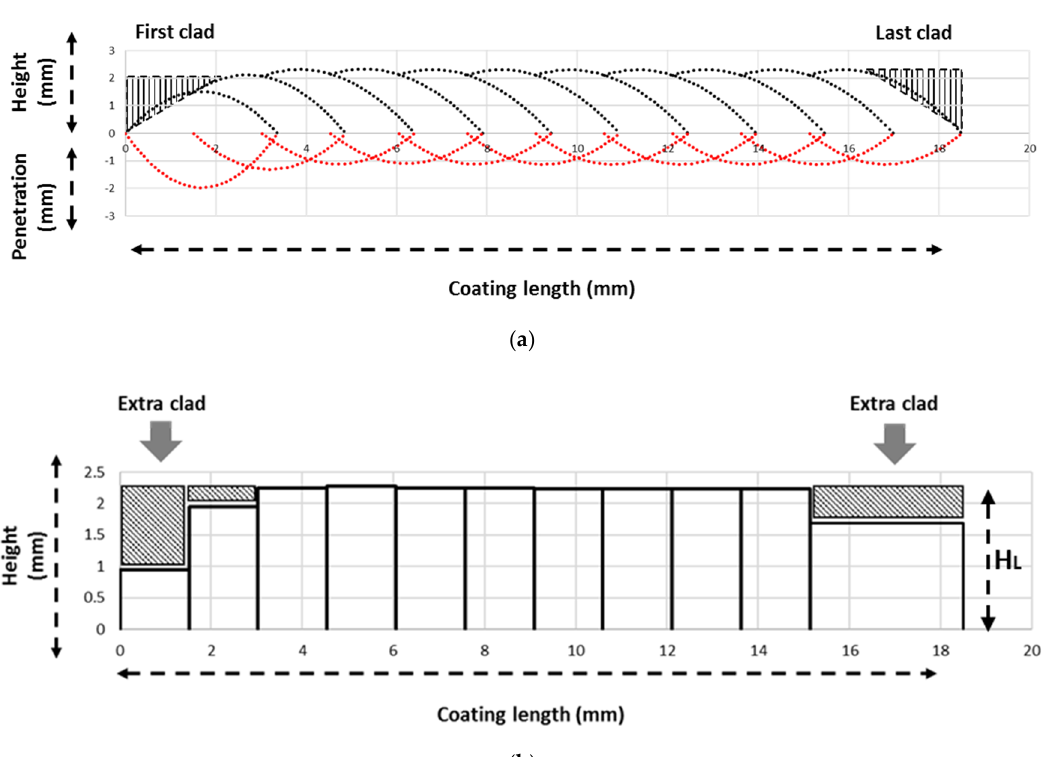
Figure 6. Lack of material predicted by the model at the layer edges. ( a ) Second degree parabola shape; ( b ) approximation to rectangular blocks.